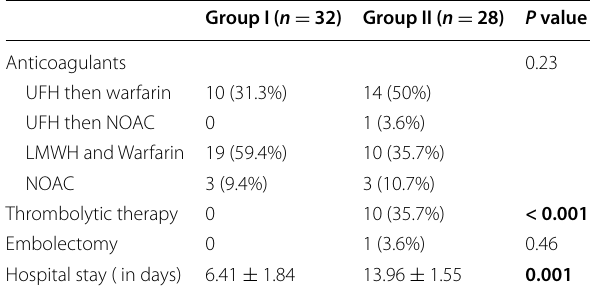
Table 6 Accuracy of parameters in prediction of high‑ intermediate‑risk